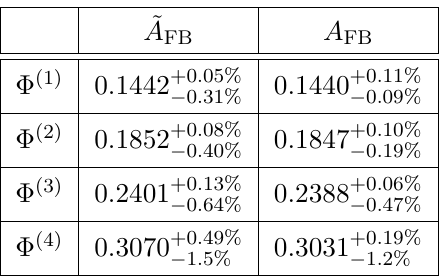
Table 3 . Forward-backward asymmetry in the invariant mass windows specified through eq. (4.5). We label as ˜ A FB the predictions including the LO contribution and higher order corrections from NLO- QCD, NLO-EW and NNLO-QCD, whereas A FB further includes the mixed QCDxEW correction computed